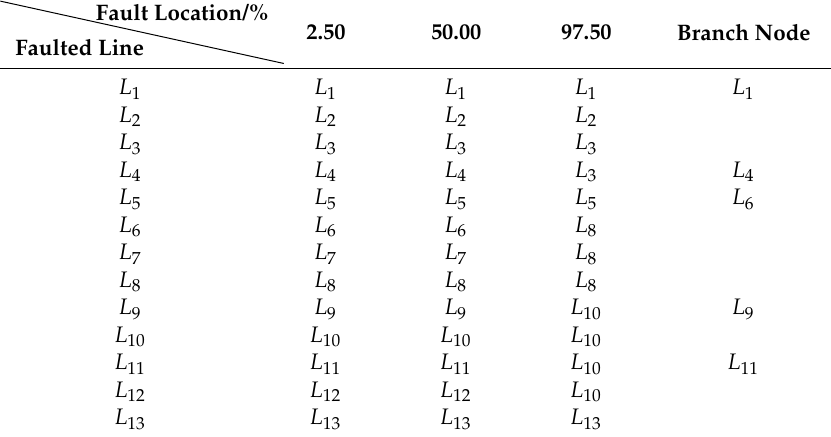
Table 6. Results of fault line selection for different fault locations at different fault